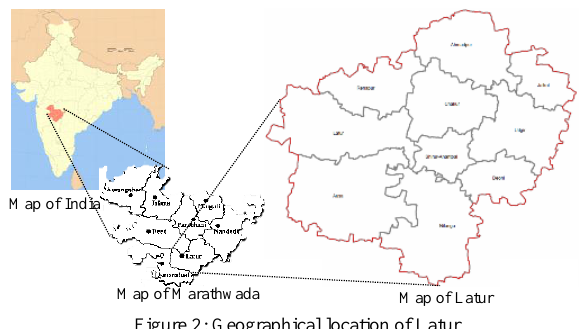
Figure 2: Geographical location of